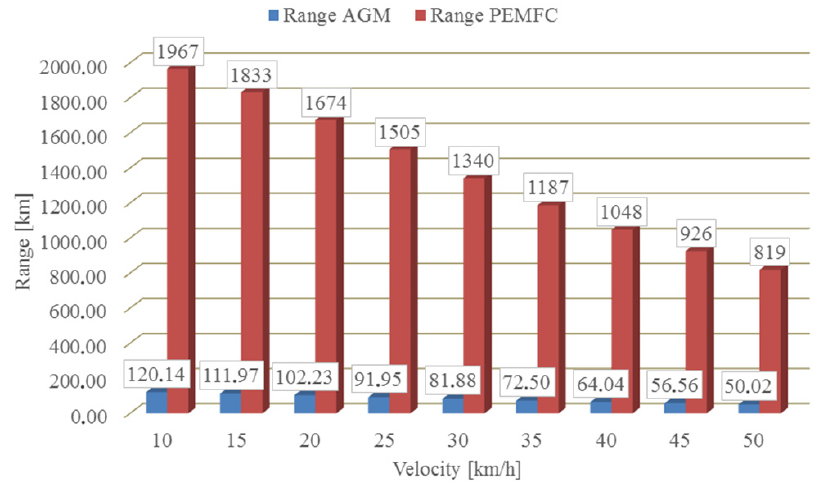
Figure 9. Range—AGM and range—PEMFC.